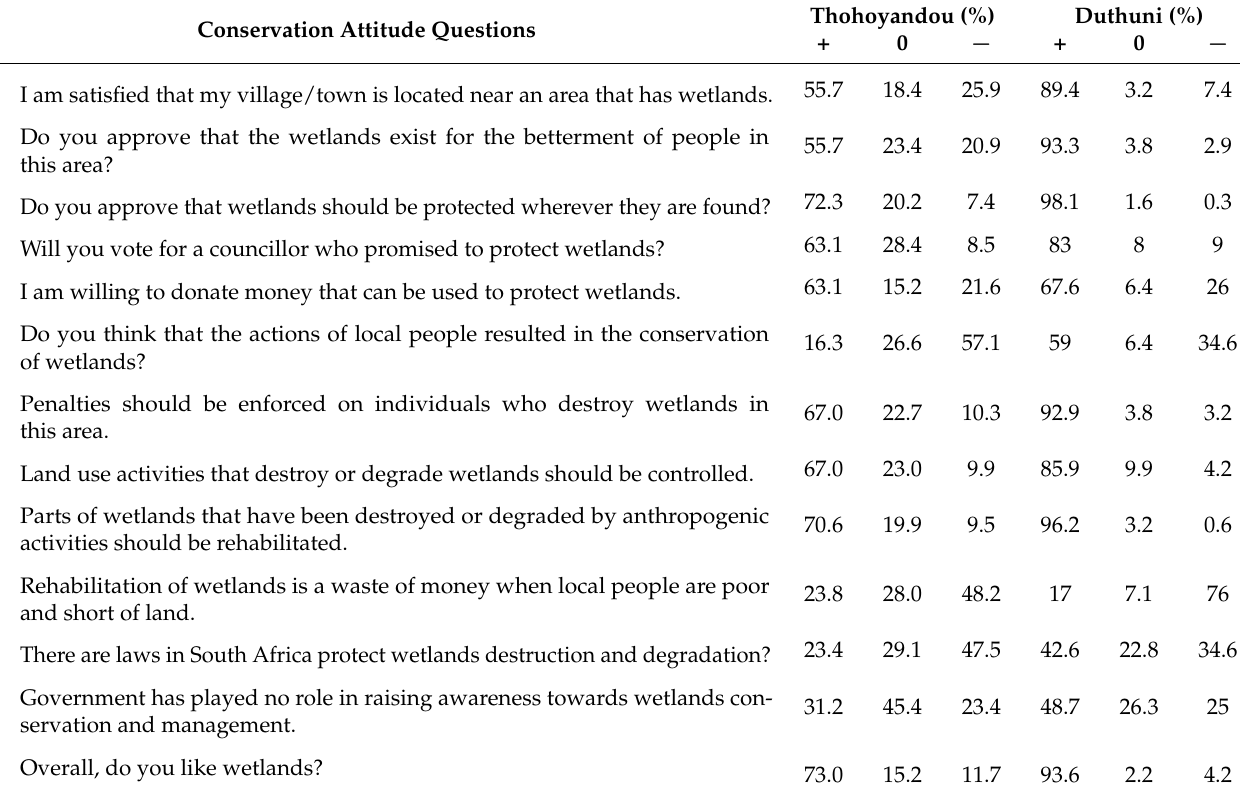
Table 3. Attitudes of community respondents towards wetland conservation in Thohoyandou ( n = 282) town and Duthuni village ( n = 312) in Limpopo Province of South